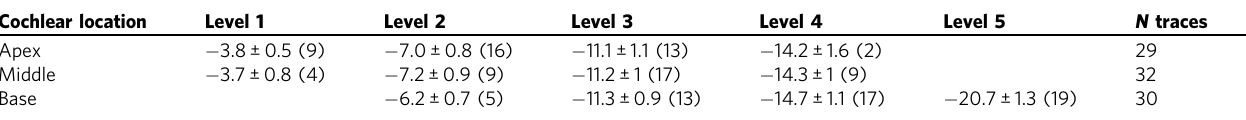
Each entry gives mean±SD of the current level in pA extracted from amplitude histograms of individual traces (Fig. 5), with the number of occurrences in parentheses. Recordings in Tmc2 − / − mice at − 84mV holding potential, with stereociliary bundles exposed to saline containing 0.04mM Ca 2